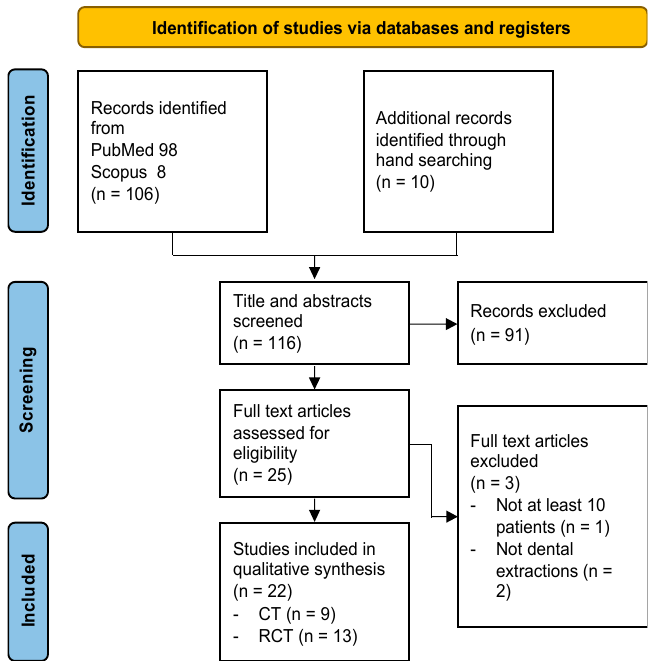
Figure 1. Literature search flowchart according to PRISMA guidelines.